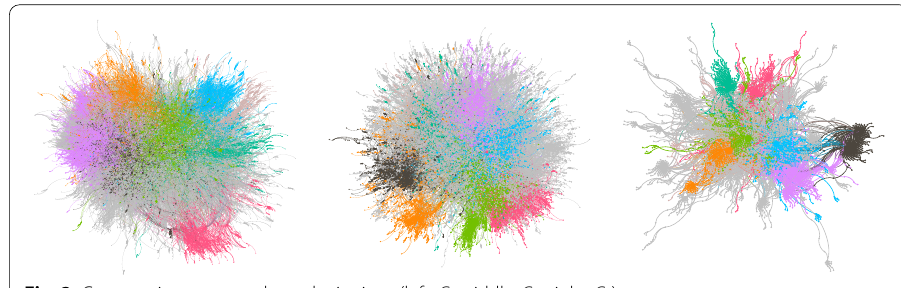
Fig. 2 Community structure through citations (left: G , middle: G P , right: G S